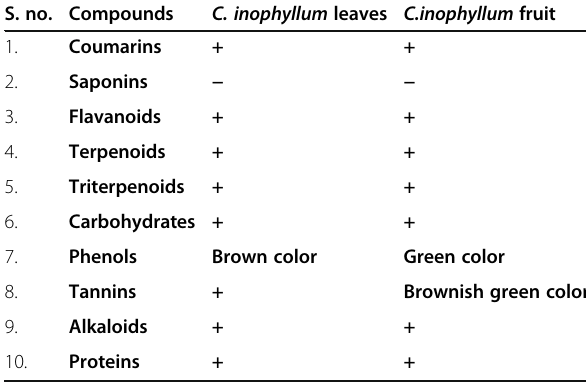
Table 2 Phyto chemicals present in the plant